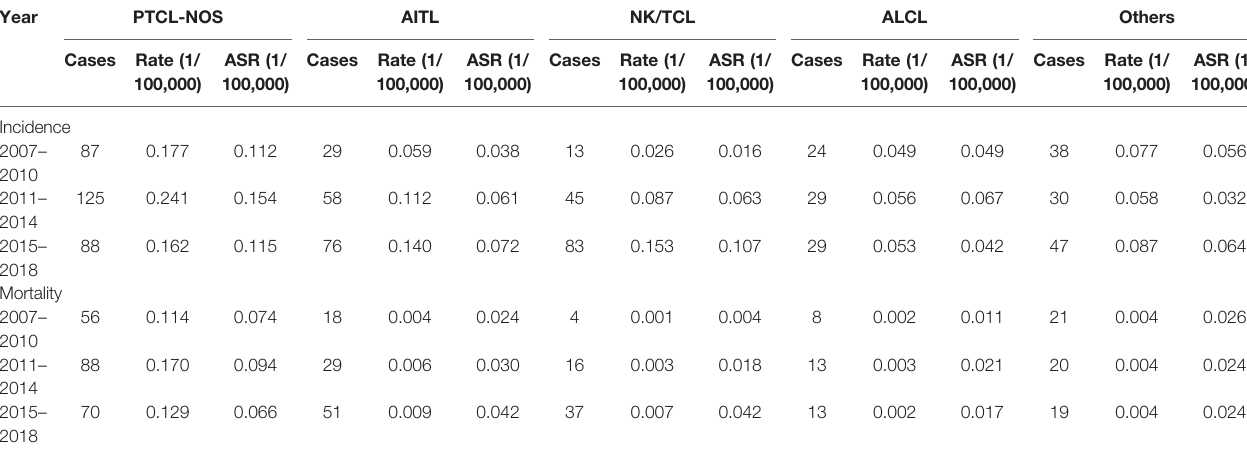
TABLE 7 | Incidence and mortality by histology type of patients with peripheral T-cell lymphoma in Beijing from 2007 to 2018. Year NK/TCL ALCL